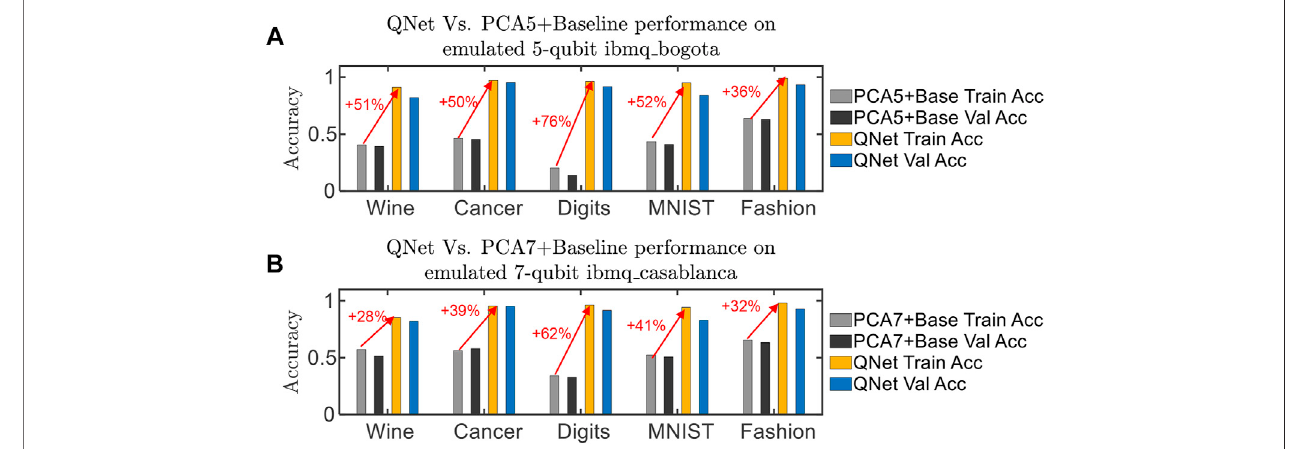
FIGURE 9 | Measured performance of trained QNet and PCA + Baseline models on hardware emulators. (A) shows performance comparison on 5-qubit ibmq_bogota where the QNet models use QQ (cid:2) 5 and the PCA + Baseline models use 5 principal components. (B) shows the performance comparison on 7-qubit ibmq_casablanca where the QNet models use QQ (cid:2) 7 and the PCA + Baseline models use 7 principal components. For QNet, we use PL (cid:2) 2, QL (cid:2) 2. For a fair comparison, we vary the number of trainable parameters in PCA + Baseline models and report the best-measured performance against QNet.